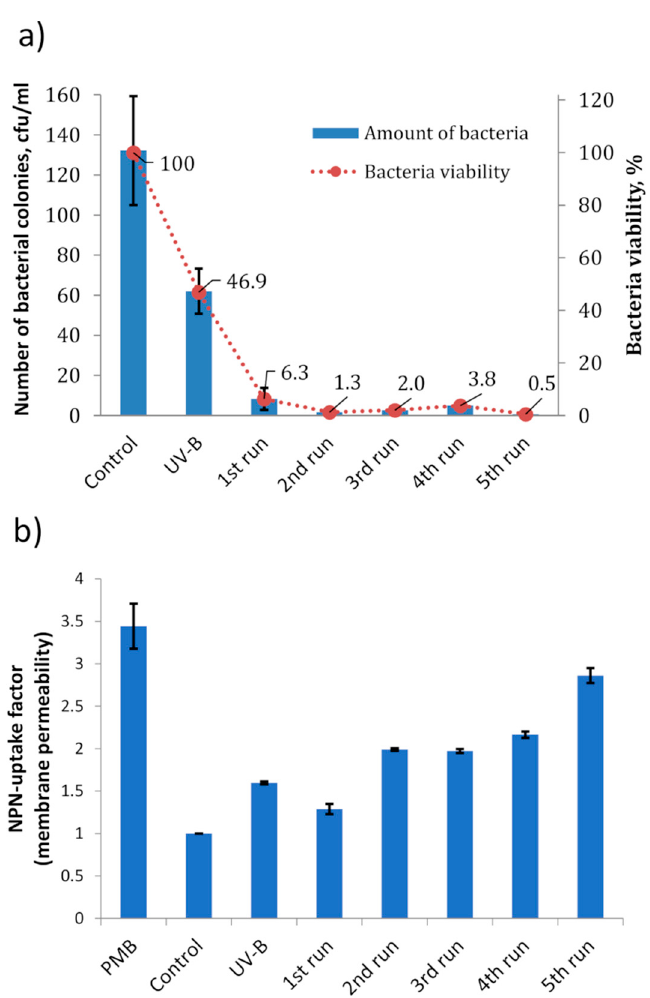
Figure 6. Results of Salmonella Typhimurium SL1344 bacterial inactivation experiment using HDPE + TiO 2 under UV-B irradiation: ( a ) bacterial viability results of cycling test; ( b ) NPN uptake factor (membrane permeability results) during each run. The experiments were performed at 37 °C, the initial number of bacteria was 3 × 10 8 cfu/mL, dilution factor of 50,000.